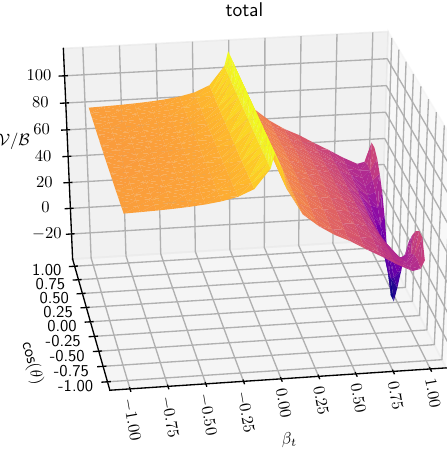
Figure 5 . Dependence of the ratio V / B on the parameters β t and cos θ , summing over all polari-